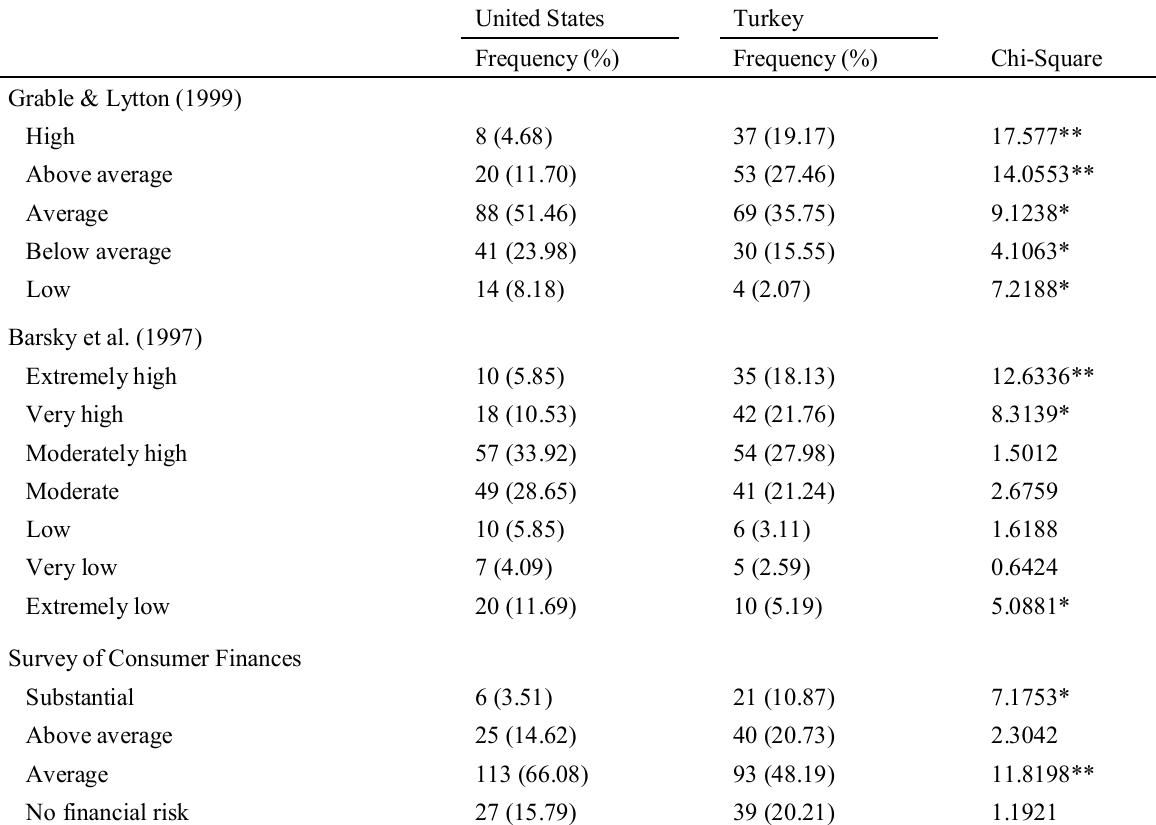
Table 2. Frequency and Bivariate Analysis Results of Risk Tolerance Measures by Category United States